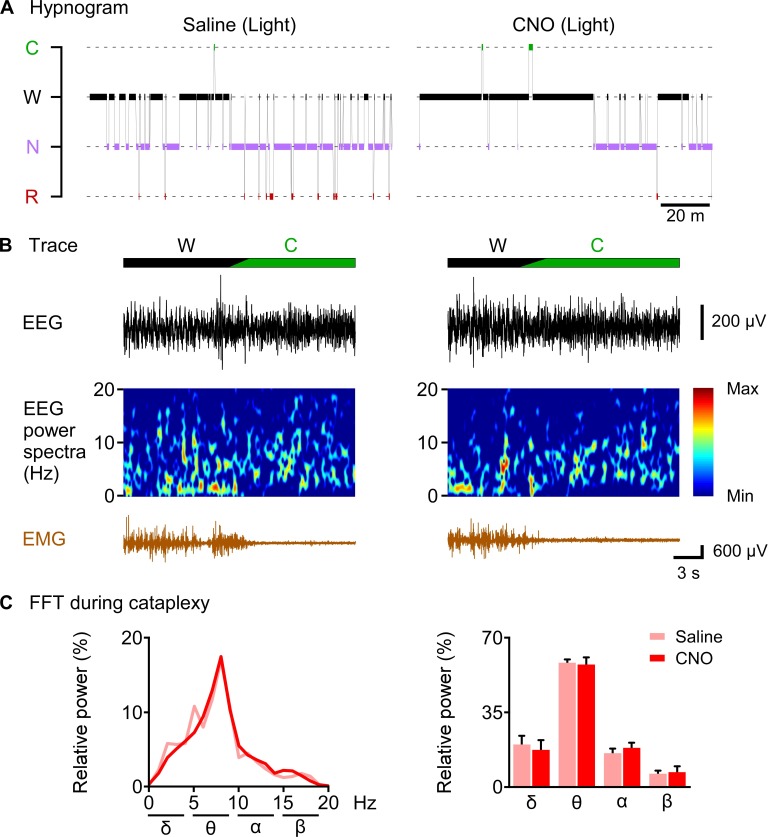
CNO-induced cataplexy was not different from naïve cataplexy.(A) hypnogram of 2 hr after saline or CNO administration. (B) typical traces showing EEG signal, EEG power spectrum and EMG of cataplexy episode. (C) line graph (left) and bar graph (right) showing relative power spectrum of EEG during cataplexy episode in the light period (n = 8 mice). Data represent the mean ± SEM in both the line and bar graph.10.7554/eLife.44927.020Figure 8—source data 1.Source data for Figure 8C.